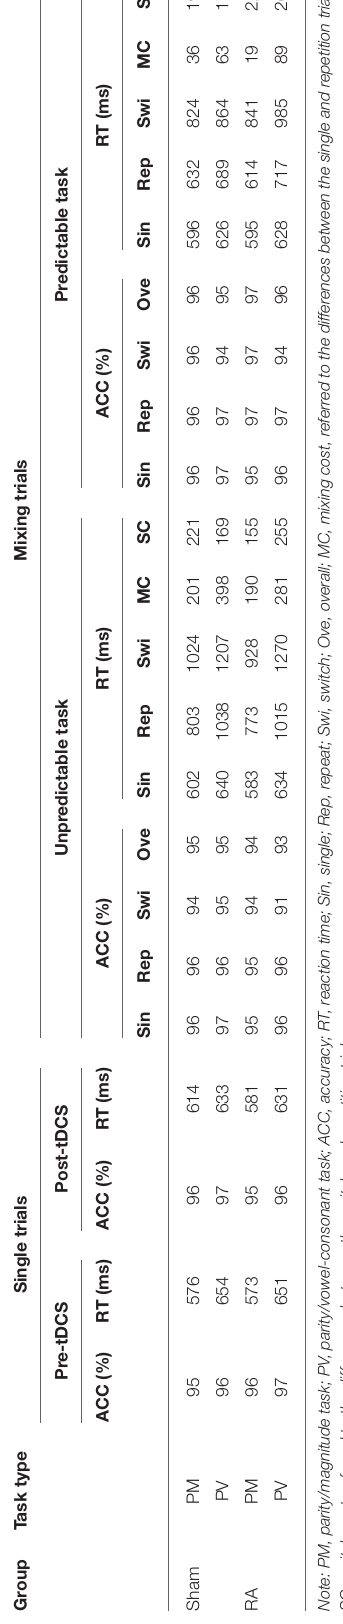
TABLE 3 | Significance statistics of single